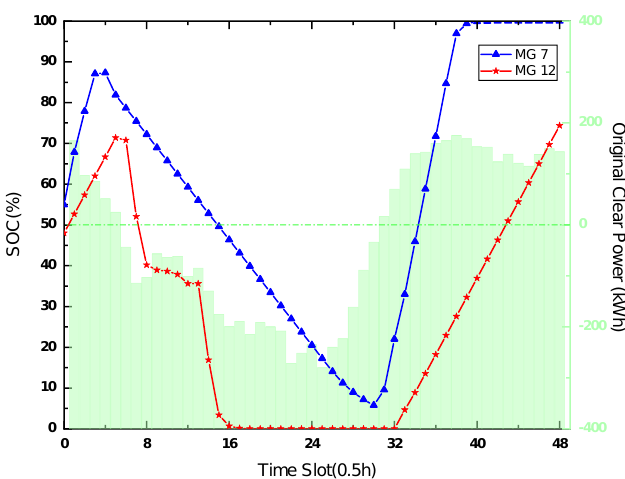
Figure 14. Battery energy storage system’s SOC on MG 7 and MG 12.